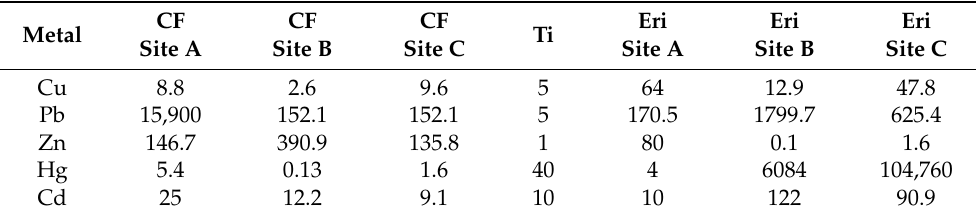
Table 3. Variation in contamination factor (CF) and ecological risk factor (Eri) in soils from mining sites within the Pawara area.